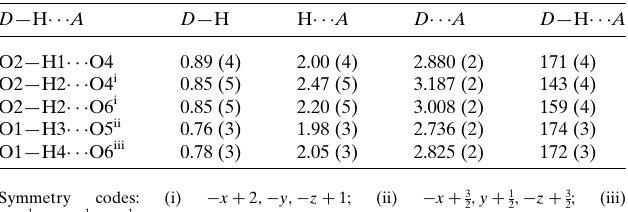
Table 1 Hydrogen-bond geometry (A˚ , (cid:5) ) for (I).